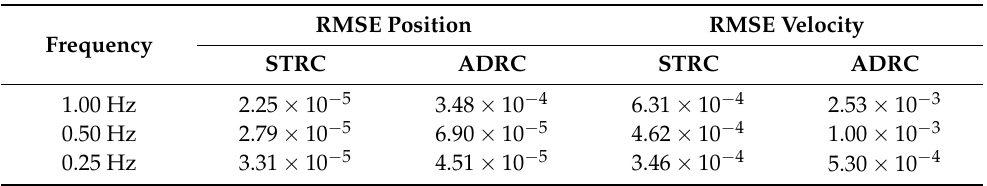
Table 4. Root mean square error for one full period at three different frequencies comparing STRC and ADRC